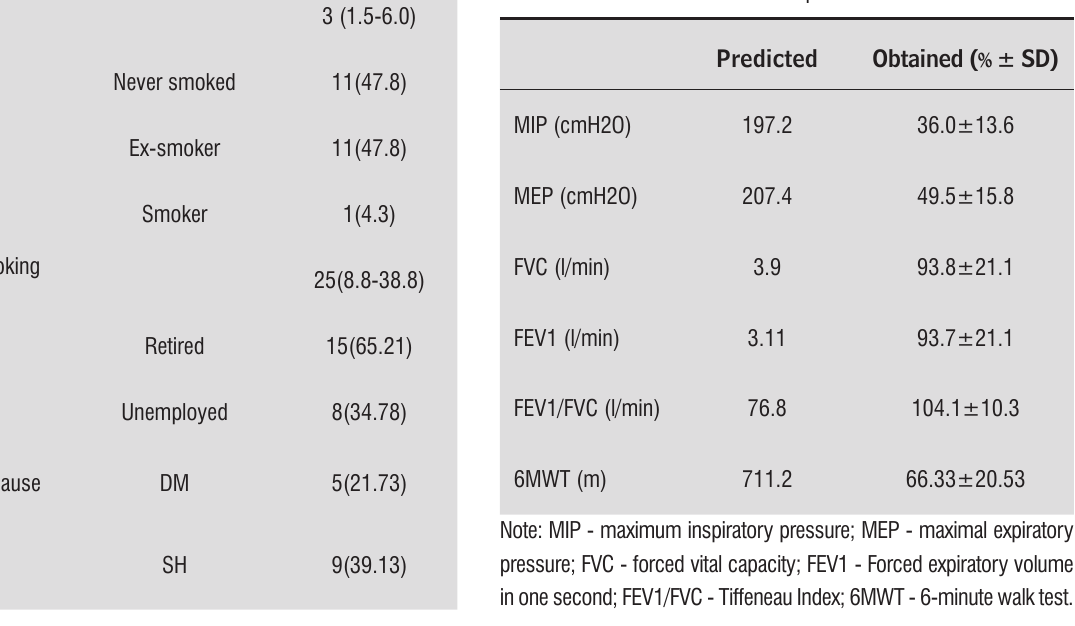
Table 2 - Characteristics of the predicted and obtained